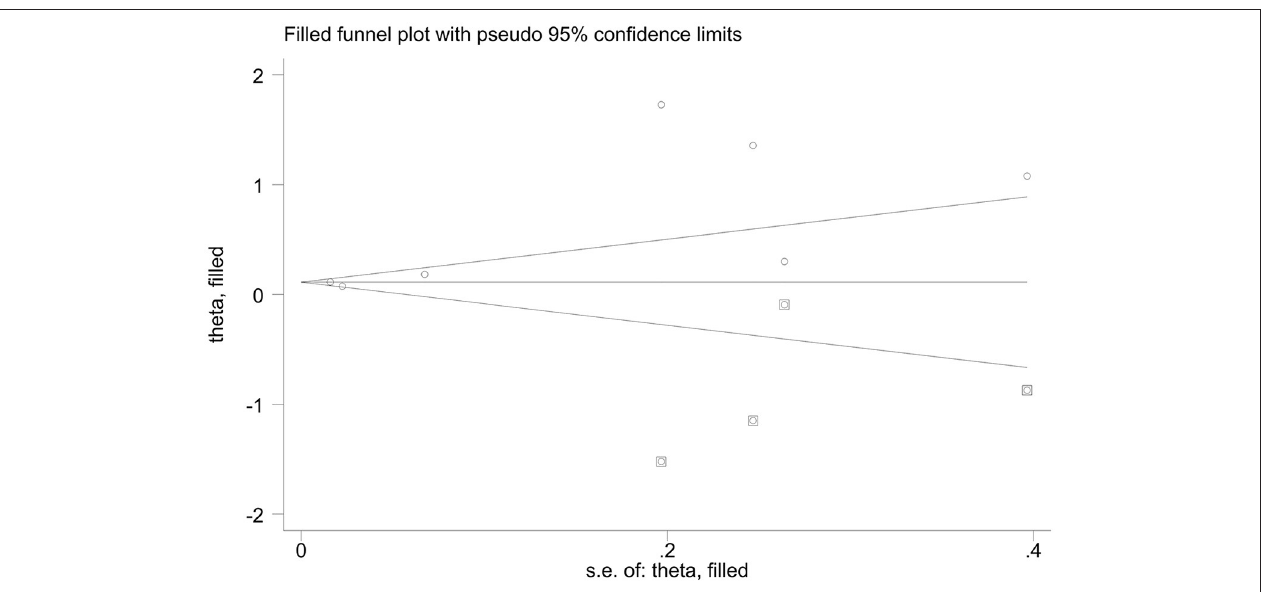
FIGURE 6 | Funnel plots of non-parametric trim-and-fill method regards the OR for various depression assessment scales estimating risk factor of